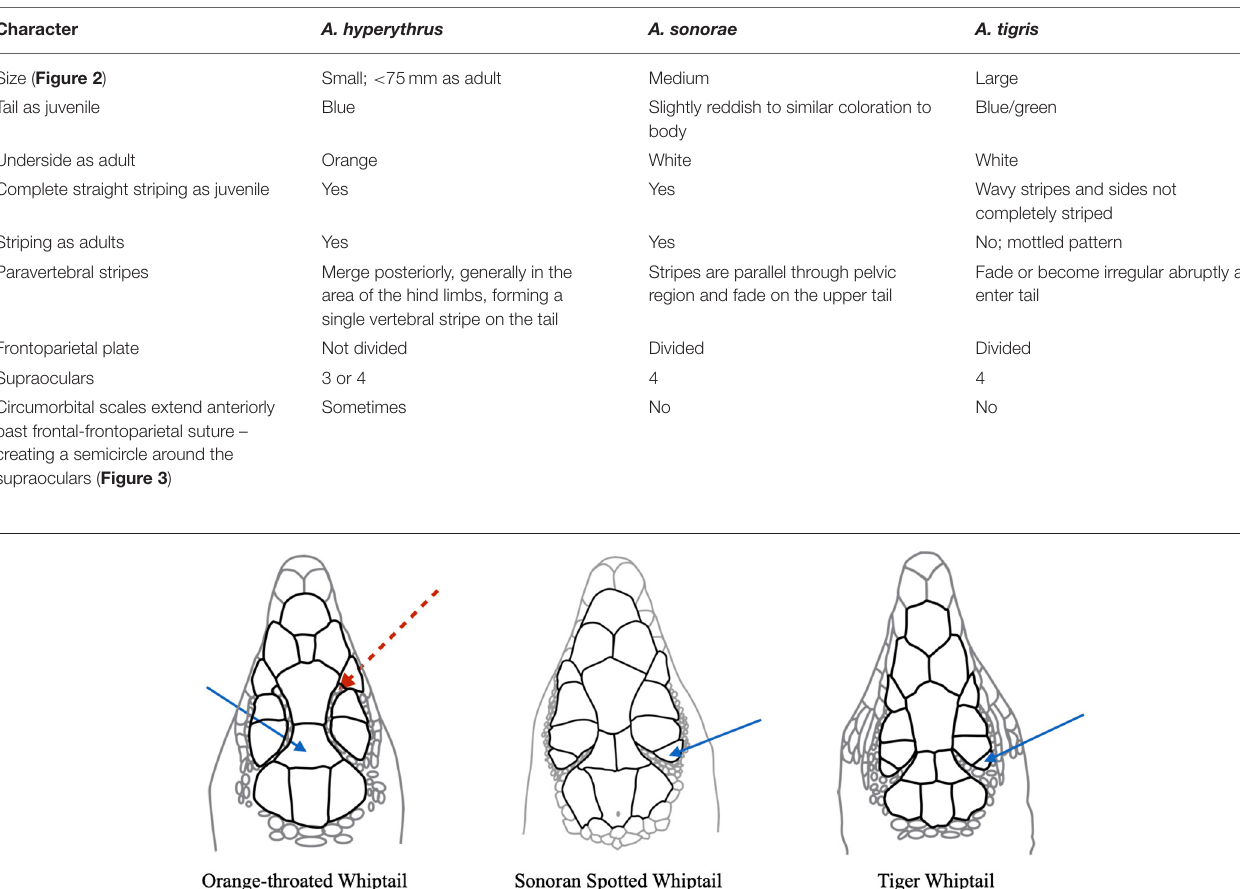
TABLE 2 | Diagnostic characteristics to distinguish between the two native species of whiptail and the invasive Sonoran Spotted Whiptail (bold) in Southern California.